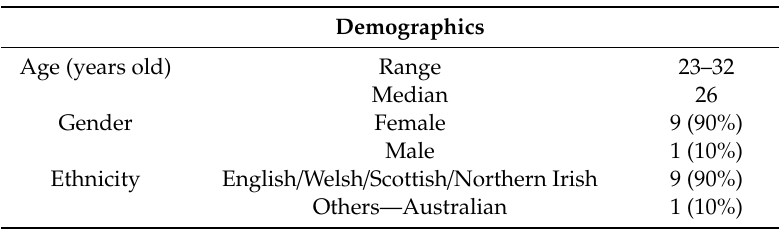
Table 2. Demographic characteristics of employees.